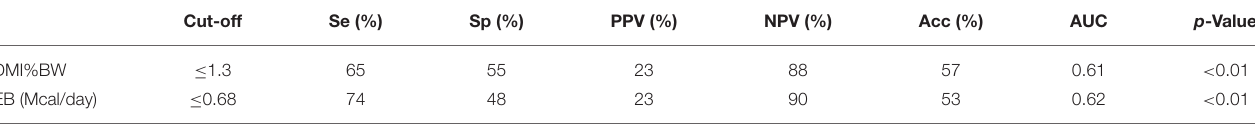
TABLE 5 | Cut-offs of dry matter intake DMI as percentage of BW (DMI%BW) and energy balance (EB) to predict indigestion postpartum. Cut-off